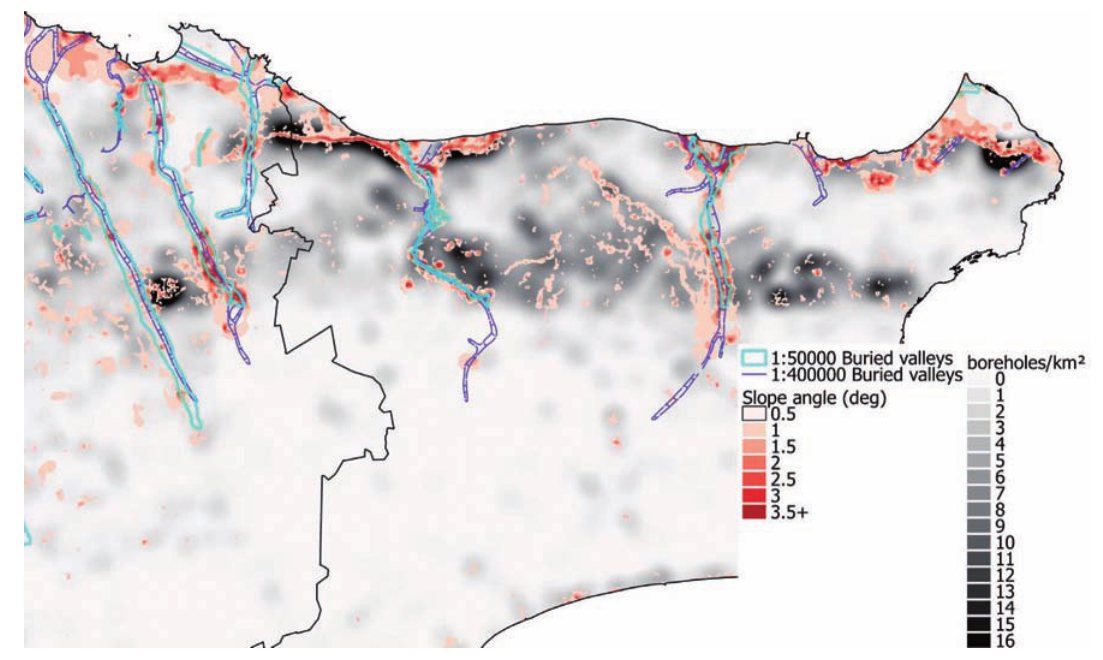
Fig. 8. The rock head elevation (RHE) model of Ida­Viru County next to the mapped buried valleys (area a in Fig. 1). The area is characterized by a high density of borehole data and the interpreted buried valleys from the geological maps (1:50 000 and 1:400 000) agree well with the interpolated slope data from the RHE model.